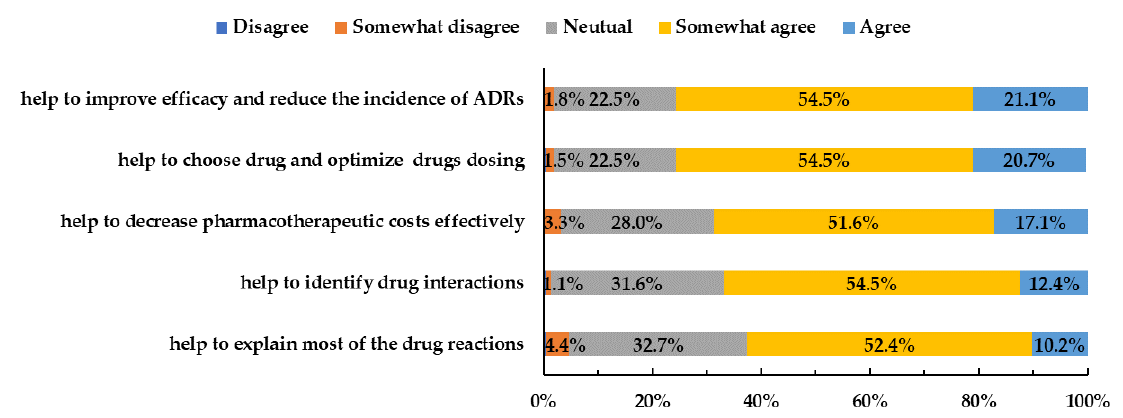
Figure 3. Physicians’ attitudes toward PGx testing.